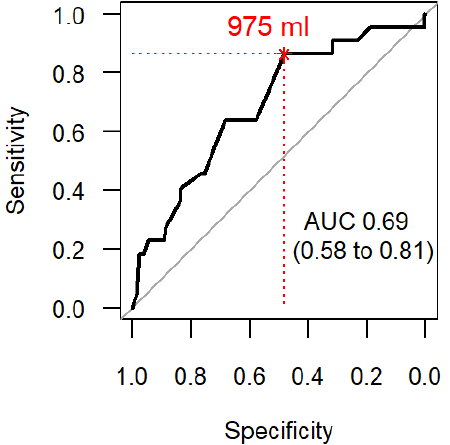
Figure 3. The receiver operating characteristic (ROC) curve for complications associated with drainage volume in 24 h (mL). The optimal threshold due to Youden’s index for the drainage volume (red number) corresponds to the point closest to the top-left marked with an asterisk. AUC: Area under the ROC curve.